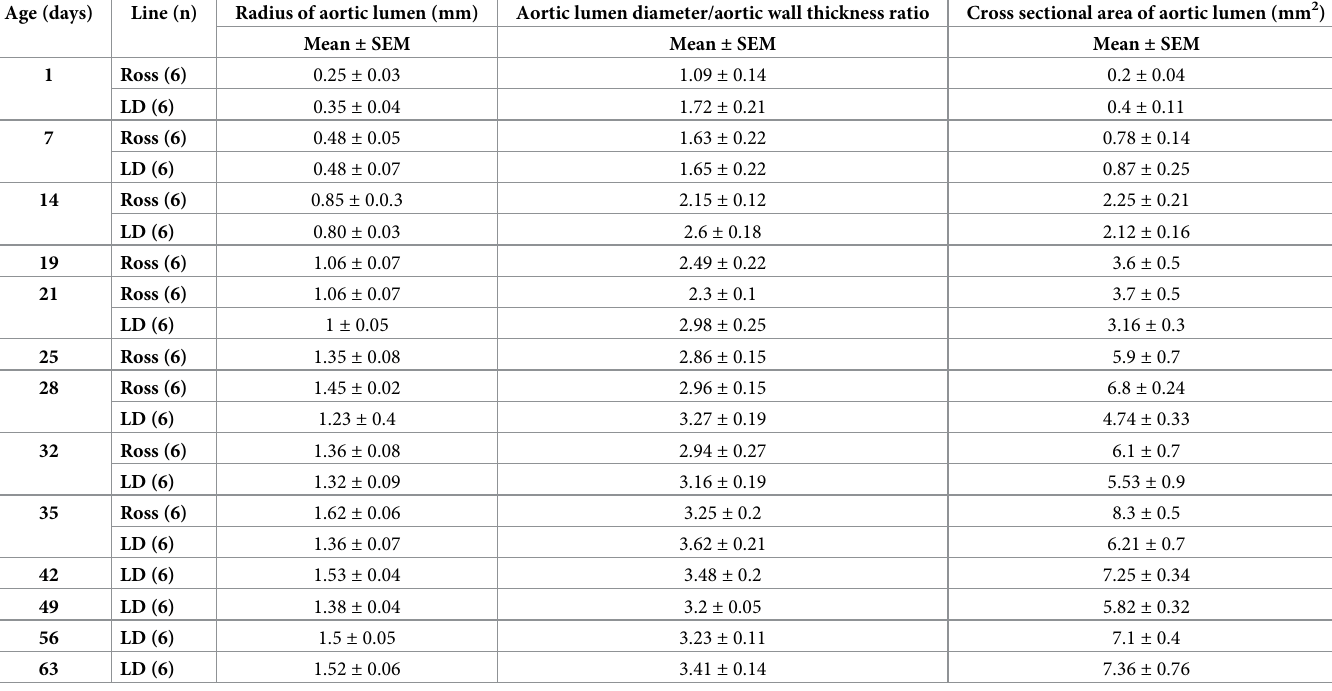
Table 5. Radius of aortic lumen, ratio of aortic lumen diameter/aortic wall thickness and cross sectional area of aortic lumen. All versus day post hatching.